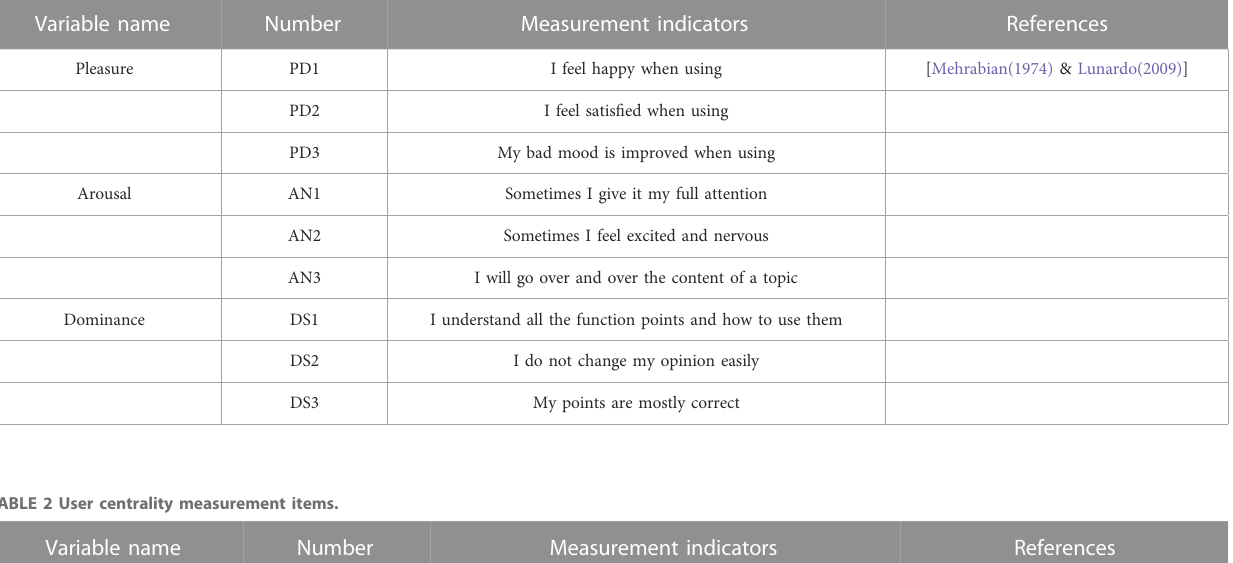
TABLE 1 PAD three-dimensional emotional model measurement items.